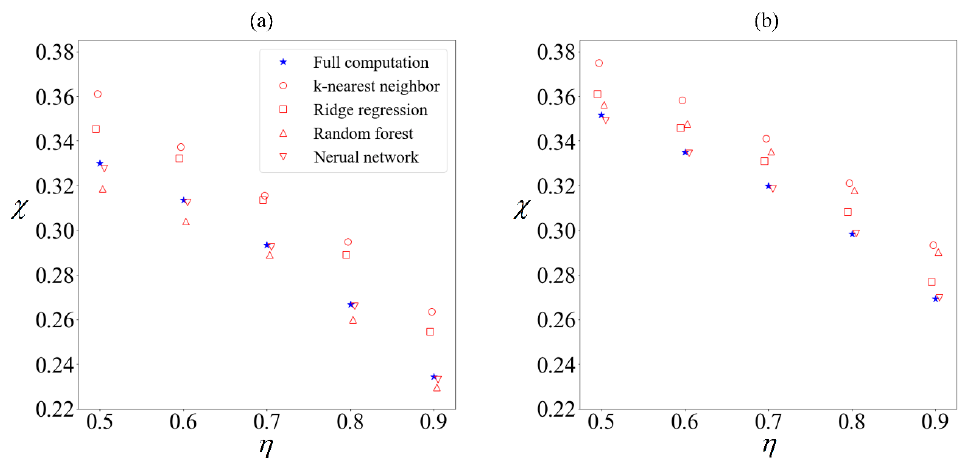
Figure 7 . ( a ) Sperm subjected to no external field, versus ( b ) sperm subjected to C 0 of − 1 mN/mm 3 . Purity χ computed using 100,000 samples (blue star) for different yield η , compared with purity obtained from supervised learning algorithms trained on 10,000 samples to predict remaining 90,000 samples (hollow red markers) using k-nearest neighbor (circle), ridge regression (square), random forest (triangle) and artificial neural network (inverted triangle).